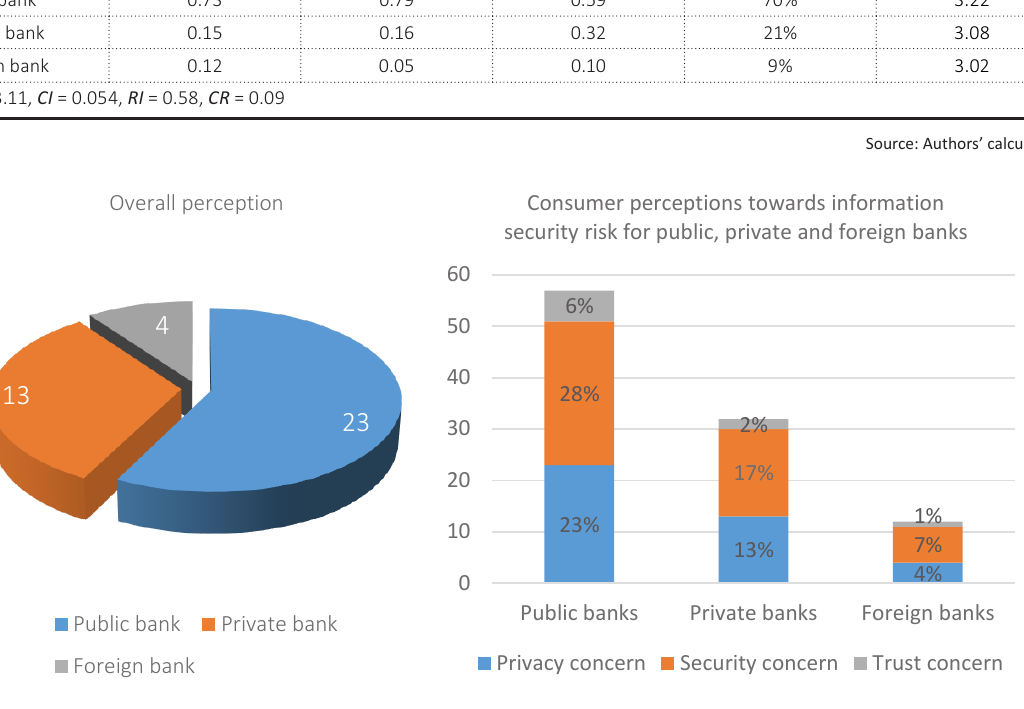
Figure 2. Weighted scores of consumer perceptions towards information security risk for public, private and foreign banks